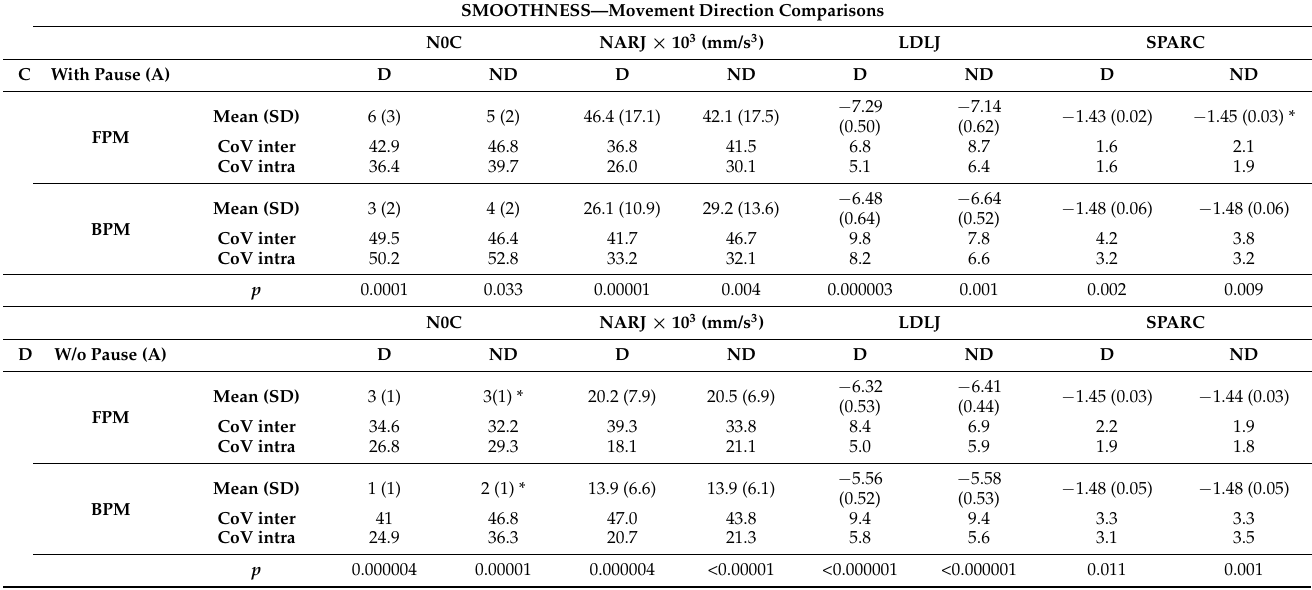
Healthy values of smoothness metrics [mean(SD)] across movements directions. ( C ) Comparison of the smoothness metrics between FPM and BPM in set A setting (with a pause). ( D ) Comparison of the smoothness metrics between FPM and BPM in set B setting (without a pause). Mann – Whitney tests were used to compute p-values. FPM: forward-pointing movement; BPM: backward-pointing